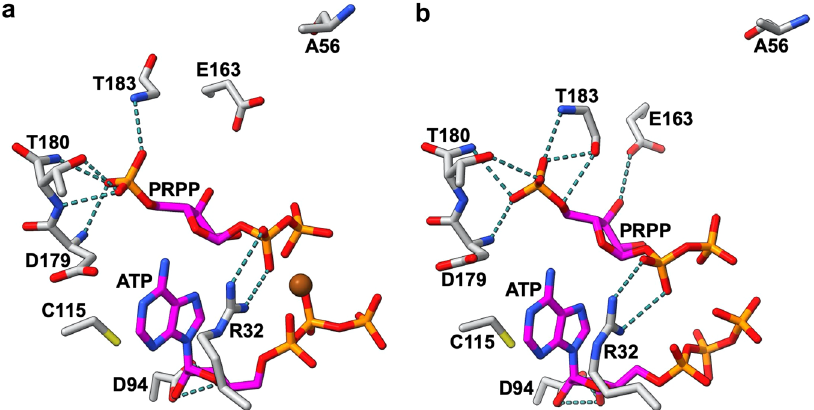
Fig. 4 | Crystal structures of R56A- Pa HisG S and R56A- Pa ATPPRT bound to PRPP:ATP. a Stick model of the active site of R56A-PaHisGS. b Stick model of the active site of R56A- Pa ATPPRT. In both panels, oxygen is shown in red, nitrogen in blue, phosphorus in orange, sulphur in yellow, and carbon in either magenta